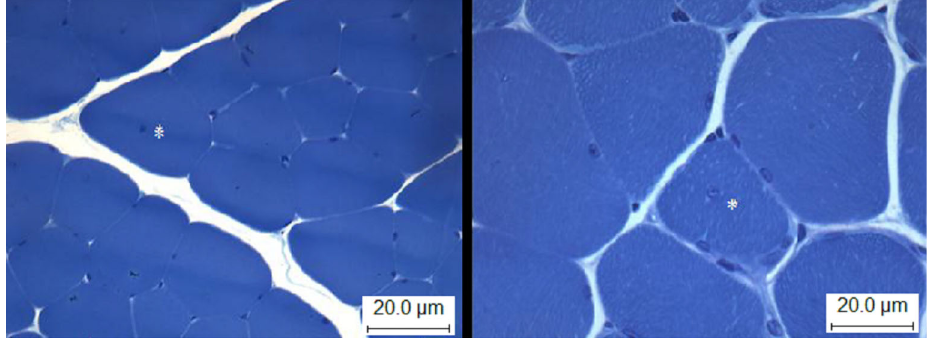
Figure 6. Soleus muscle of sedentary ischemic animals. Muscle fi ber cross-sectional area. *Nuclei displacement towards the interior of the muscle fi ber. Staining: toluidine blue + sodium borate. Bar: 20.0 m